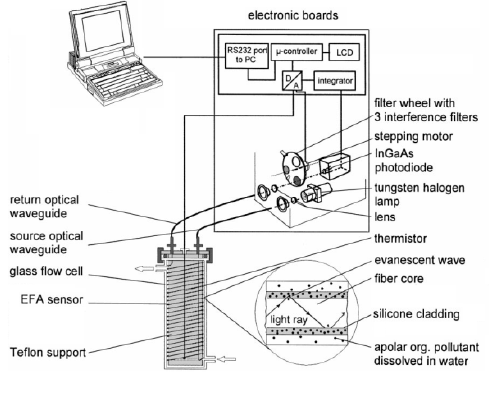
Figure 15. Evanescent field absorption sensing principle and instrumental set-up of coiled fiber-optic sensor installed in a flow cell and and NIR bandpass filter photometer unit